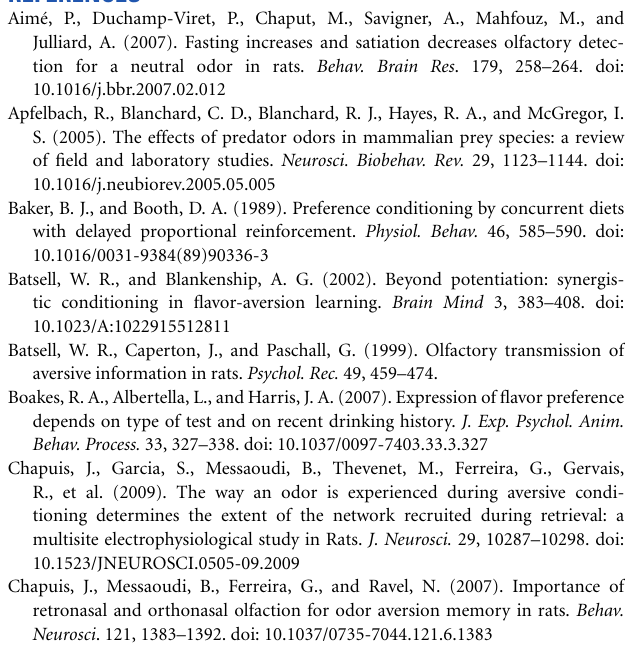
FIGURE 5 | Variations of preference for 6 odors in experiment 3, suggesting changes in the reward value after conditioning. Each odor used in experiment 3 is represented on a portion of the circle. On each of these portions, a scale represents the proportion of licks. Each portion of circle (i.e., each odor) is connected to another one to compare the preference (indicated by the proportion of licks) between these two odors: the larger the